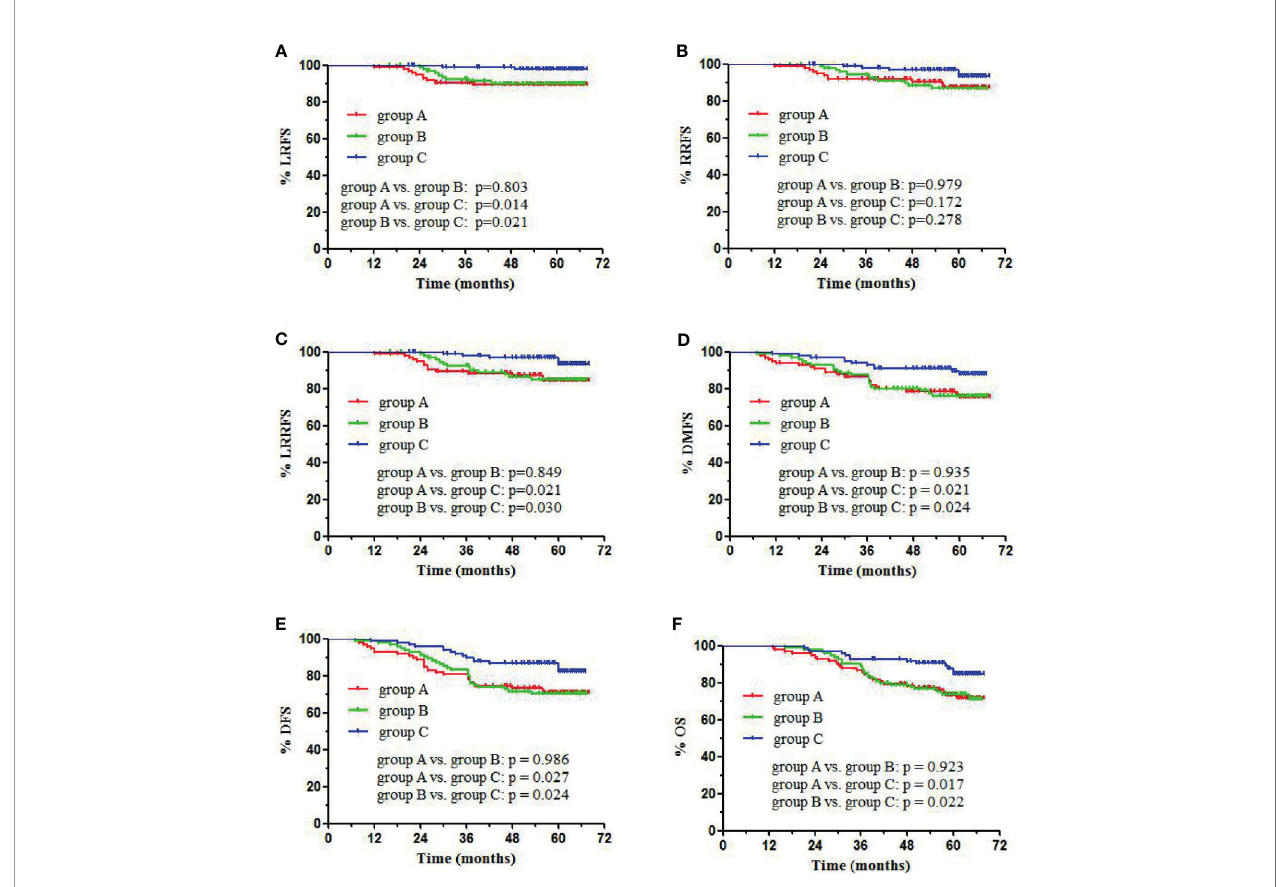
FIGURE 1 | Kaplan-Meier survival curves of different groups: visual criteria, SUV2.5, and 50% SUVmax group. (A) LRFS, (B) RRFS, (C) LRRFS, (D) DMFS, (E) DFS, (F)